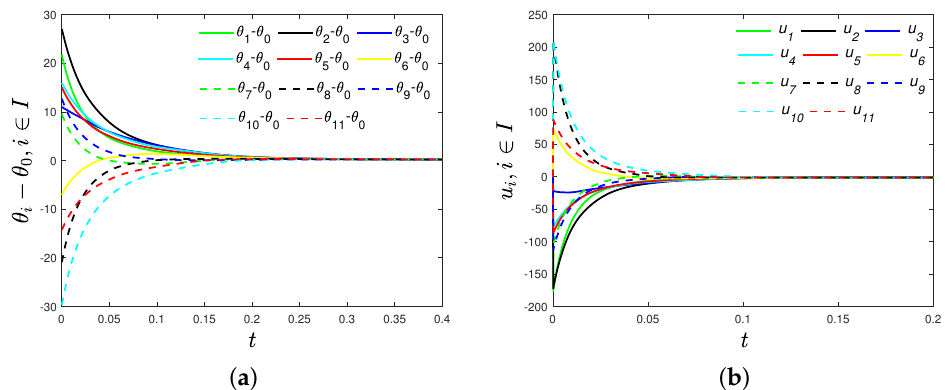
Figure 2. ( a ) Time evolutions of phase differences θ i - θ 0 ( i ∈ I ) under the distributed control strategy (6); ( b ) time evolutions of the distributed control strategy (6).